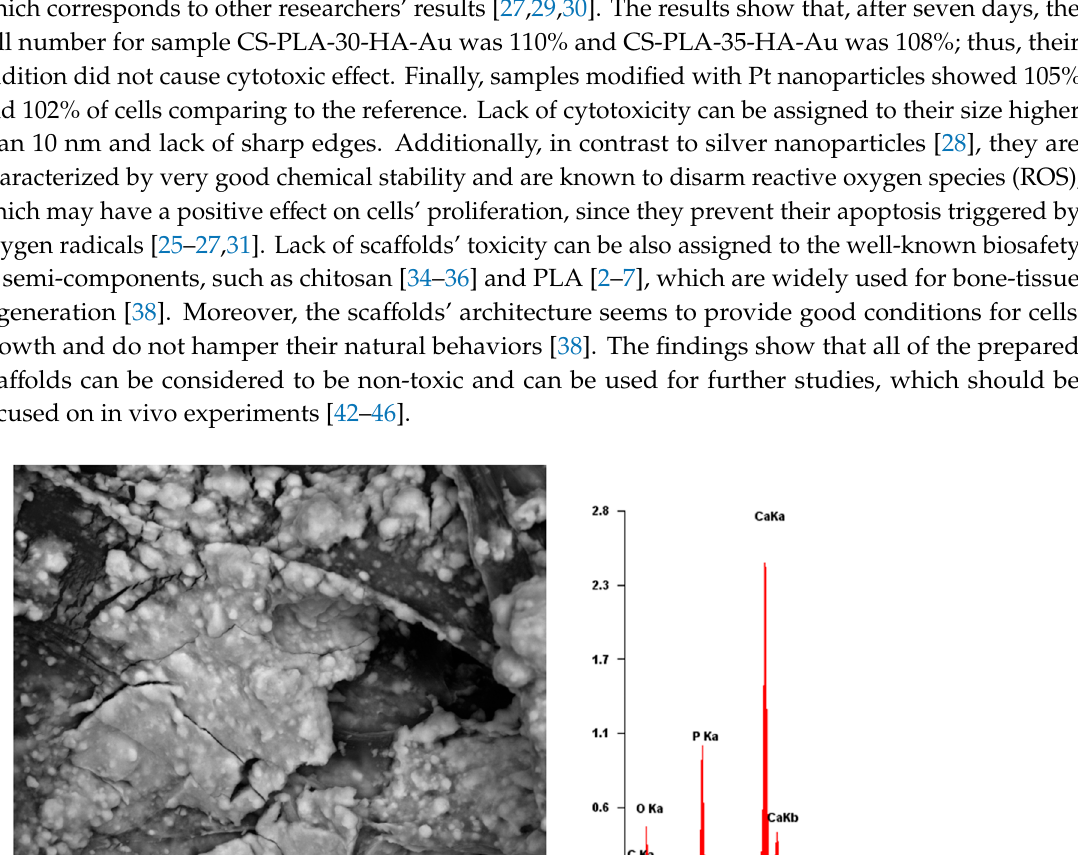
Table 2. Biomineralization efficiency after seven days of incubation in SBF.